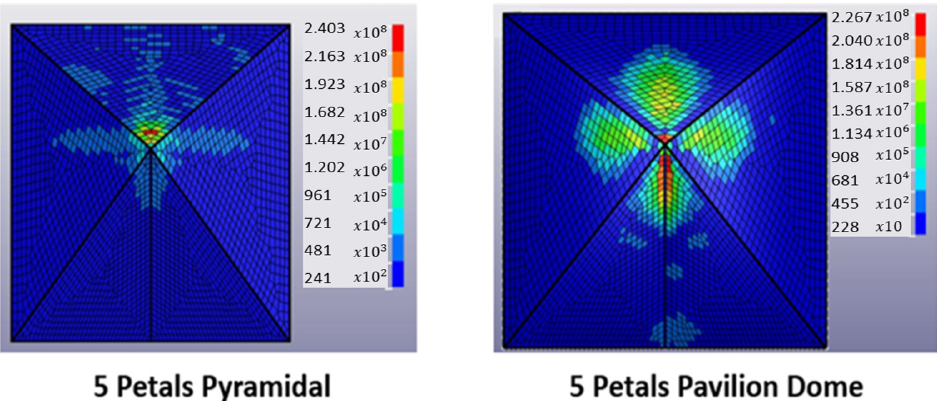
Figure 15. Pyramidal and Pavilion Dome Tailgate Configuration: Stress Distribution.